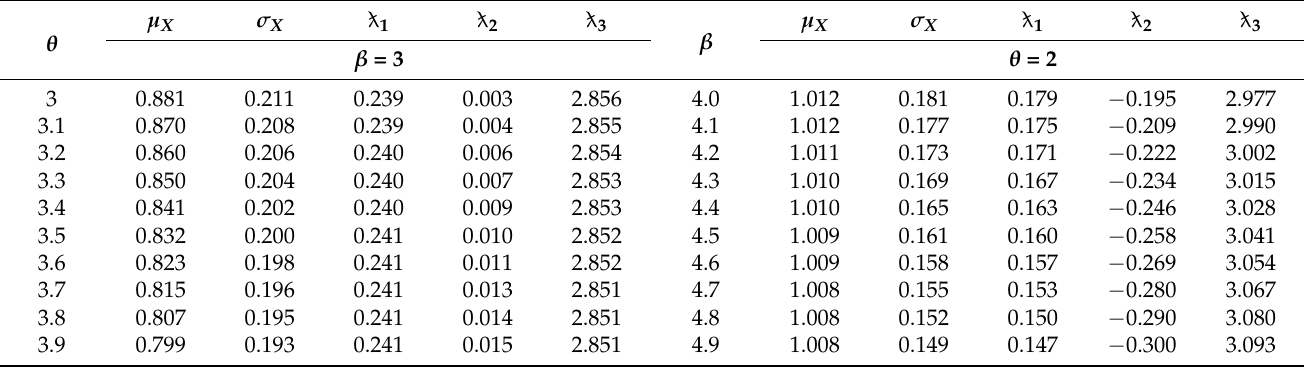
Table 1. Values of µ X , σ X , ň 1 , ň 2 , ň 3 for the PZD for selected parameters.